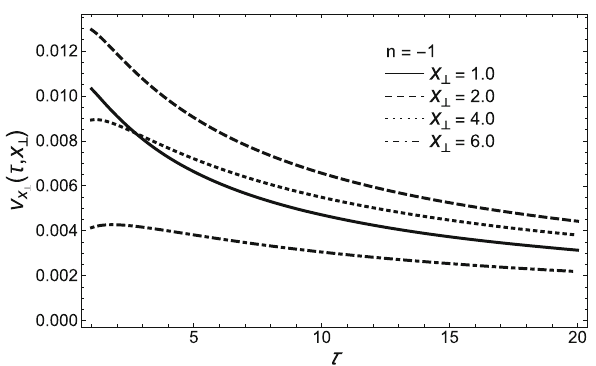
Fig. 4 v x ⊥ as a function of τ for different values of x ⊥